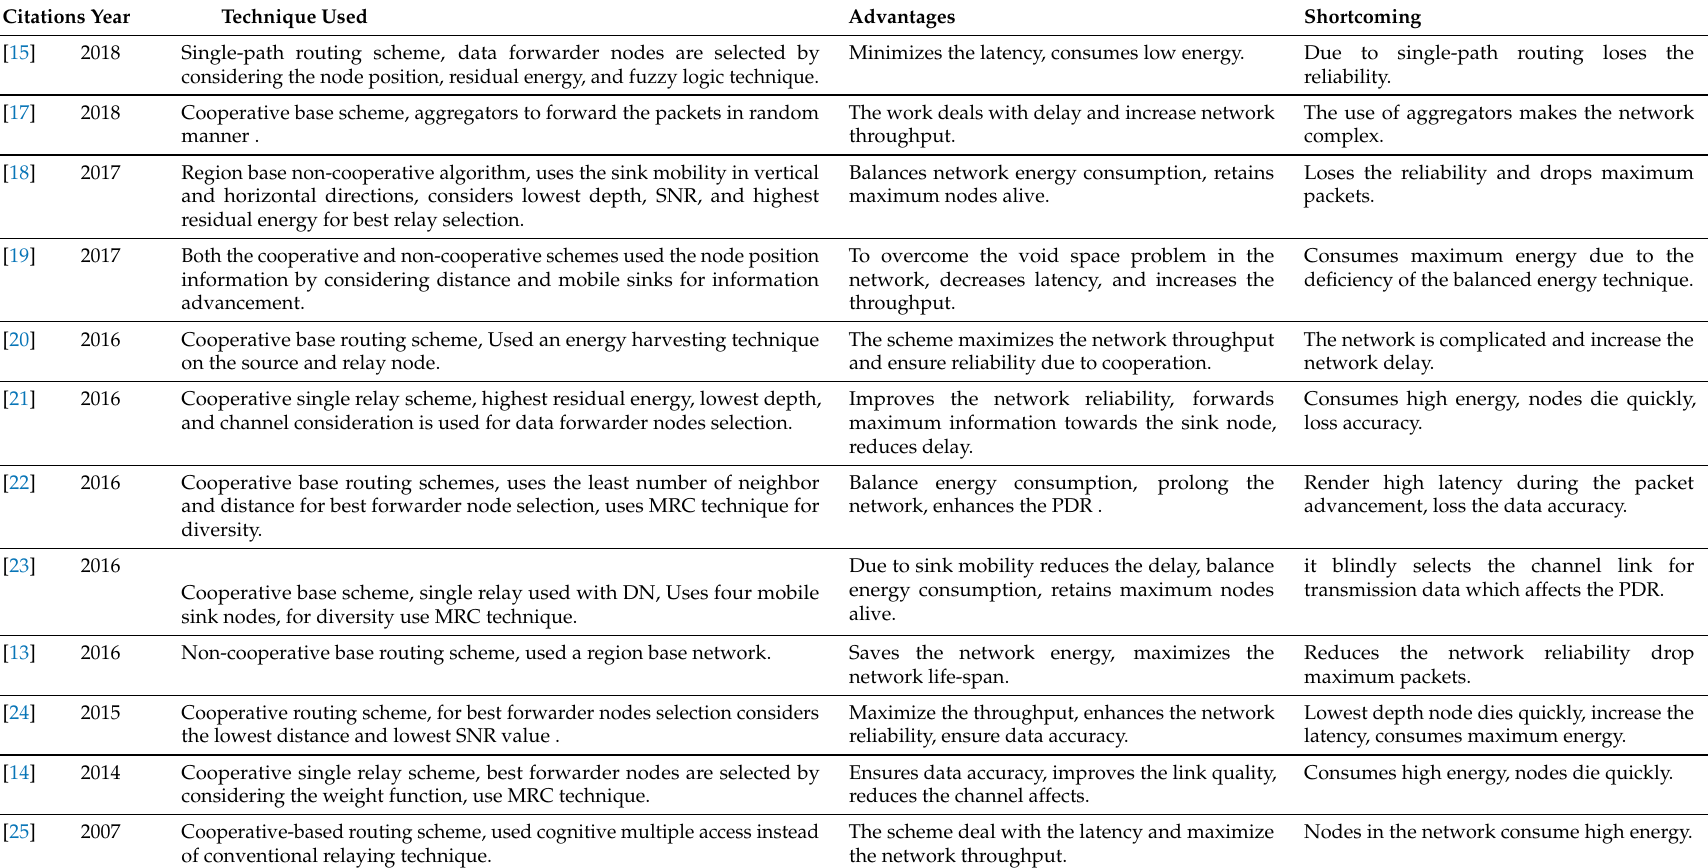
Table 1. Overview of the recently published